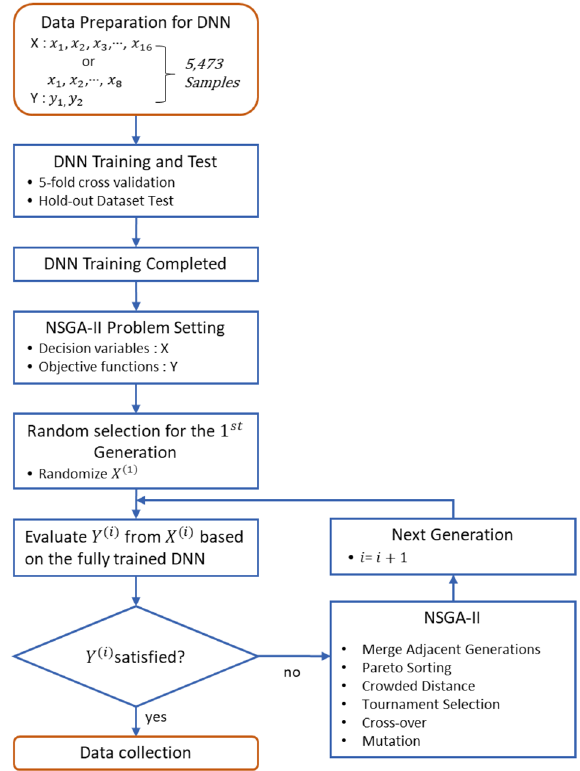
Figure 6. The flow chart briefly describing the NSGA-II algorithm execution.